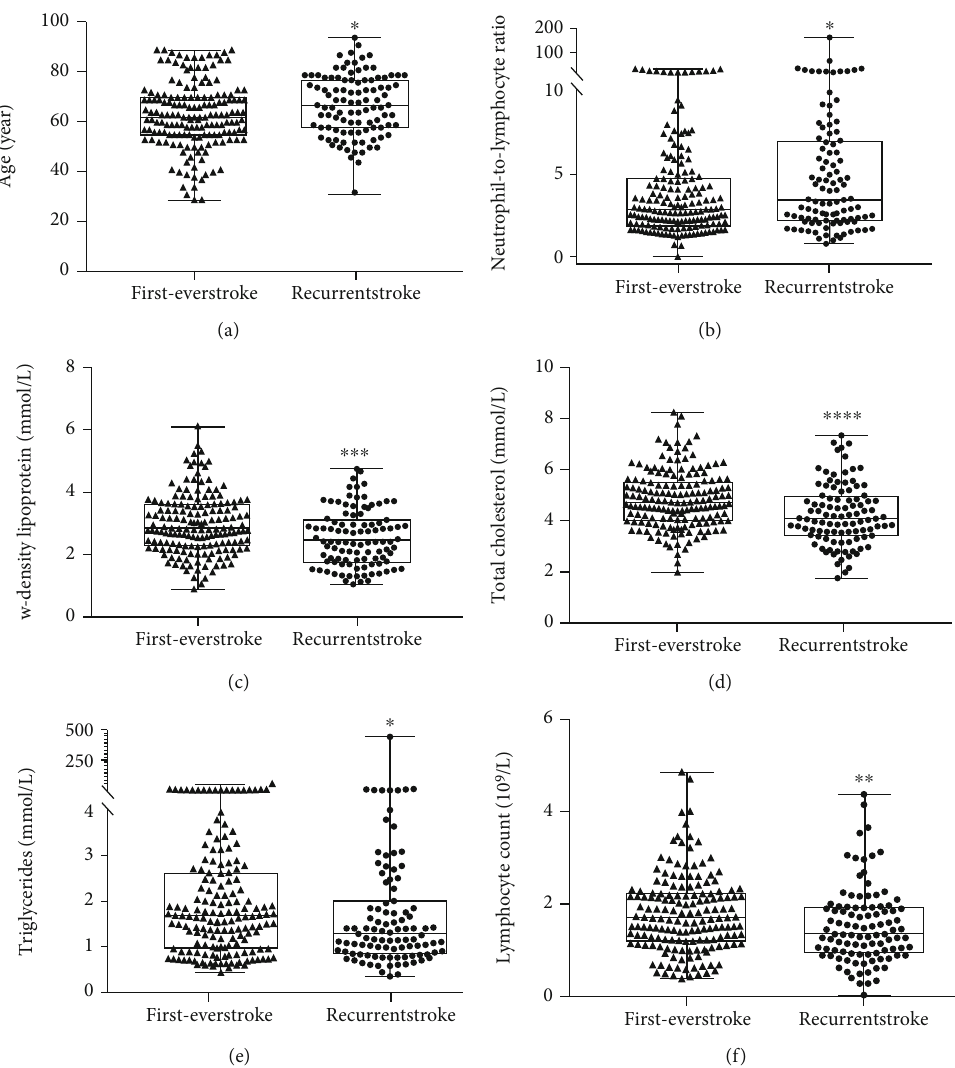
Figure 4: Signi fi cant di ff erences were found in baseline data between patients with recurrent stroke and those with fi rst-ever stroke. Patients with fi rst-ever stroke were younger (a), and the neutrophil-to-lymphocyte ratio (b) was higher in patients with recurrent stroke; patients with fi rst-ever stroke had higher low-density lipoprotein content (c), total cholesterol levels (d), total triglyceride levels (e), and lymphocyte count (f) than patients recurrent stroke. ∗ p < 0 : 05 , ∗∗ p < 0 : 005 , and ∗∗∗ p < 0 : 001